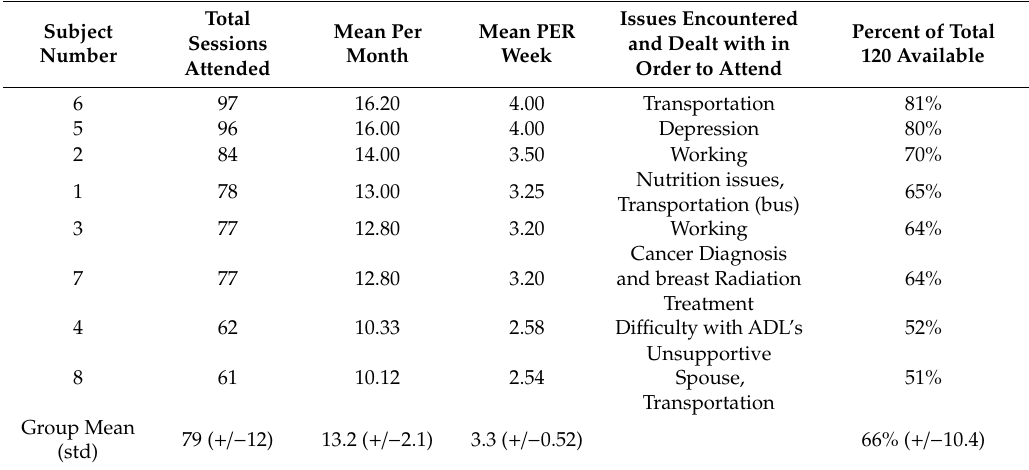
Table 4. Sessions Attended (120 possible, 6 months, 5 sessions /